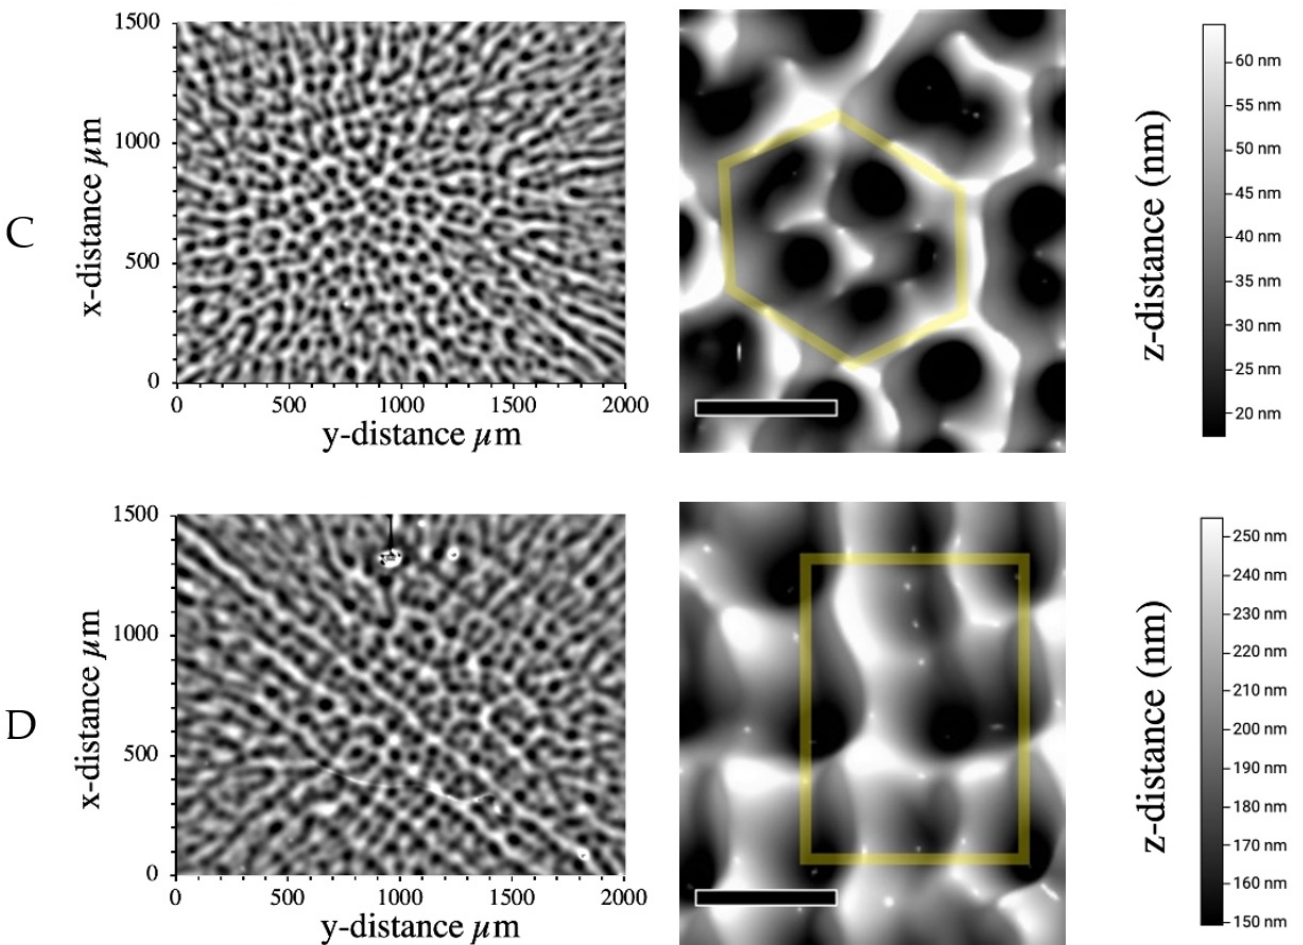
Figure 1. Optical micrographs showing surface morphology at the spinning center of PMMA films prepared from various concentrations and spin speeds. ( A ) Surface profile of 290 nm thick PMMA film cast from a 2.5 g/dL solution at 400 RPM. ( B ) Surface profile of 105 nm thick PMMA film cast from a 2.5 g/dL solution at 3000 RPM. ( C ) Surface profile of 305 nm thick PMMA film cast from a 4.0 g/dL solution at 1200 RPM. ( D ) Surface profile of 550 nm thick PMMA film cast from a 6.0 g/dL solution at 1200 RPM. Micrographs on the left are large area, 1500 × 2000 mm 2 while the micrographs on the right are 310 × 275 nm 2 . The scalebar for the micrographs on the right is 100 nm. The gray-scale z-scale on the right applies to both micrograph magnifications.